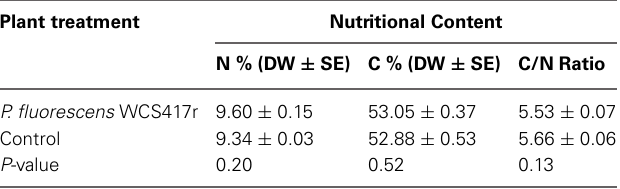
Table 3 | The N (nitrogen), and C (carbon) contents of B. tabaci adults, after 6 days of feeding on P. fluorescens WCS417r pre- or non-inoculated